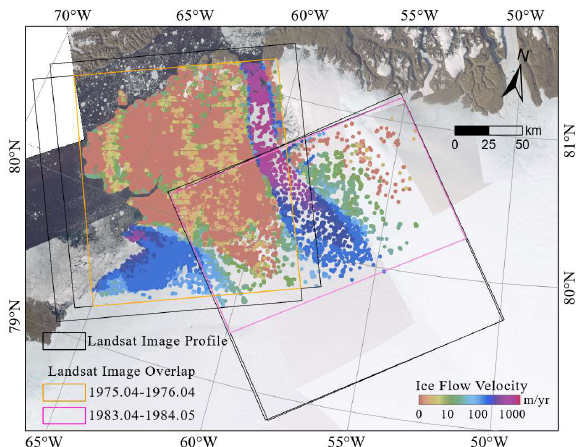
Figure 4 . Matching results for Petermann and Humboldt glaciers in North Greenland using early Landsat images (1975.04-1976.04 and 1983.04-1984.05). The black boxes are the ranges of matched images. The orange and pink boxes indicate the range of the two matching periods respectively. The background is from Landsat Image Mosaic of Greenland (Chen et al., 2020).